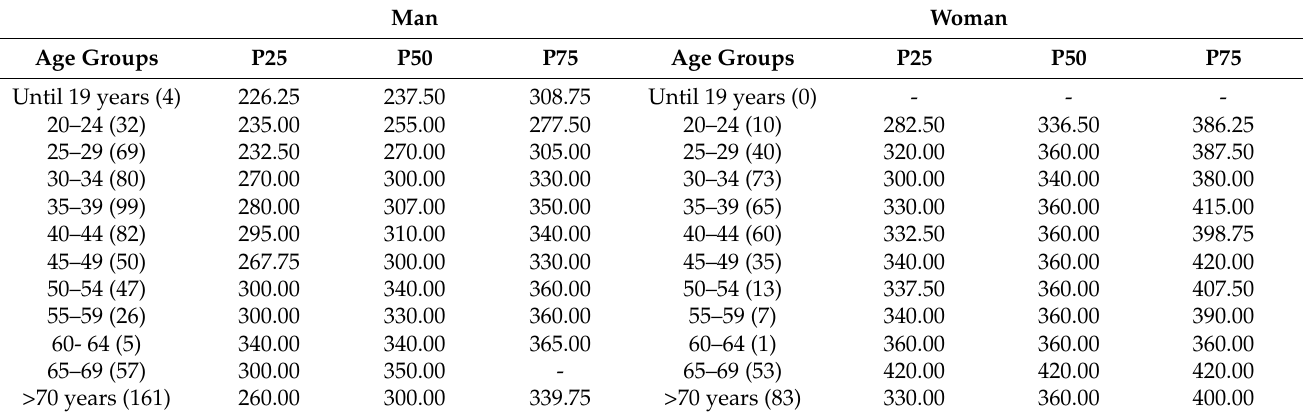
Table 2. Running pace (seconds/km) percentiles, by age-groups and sex.